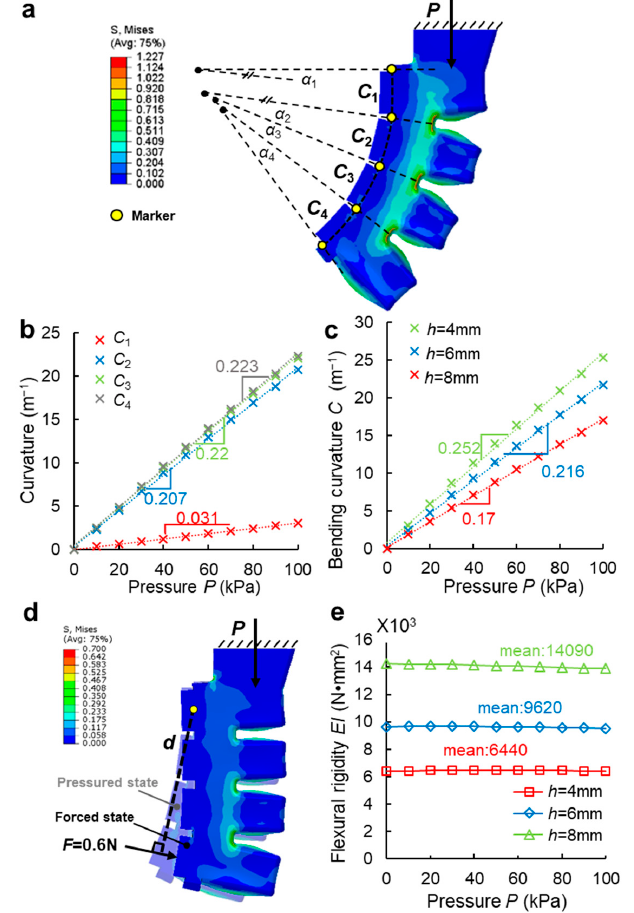
Figure 2. ( a ) The finite element model of the bending curvature of the SPAA. ( b ) The curvature of four PNs when the SPAA under pressure drive. ( c ) The bending curvature of three SPAAs with different rib heights under pressure drive. ( d ) The finite element model of the flexural rigidity of the SPAA. ( e ) The flexural rigidity of three SPAAs with different rib heights under pressure drive.